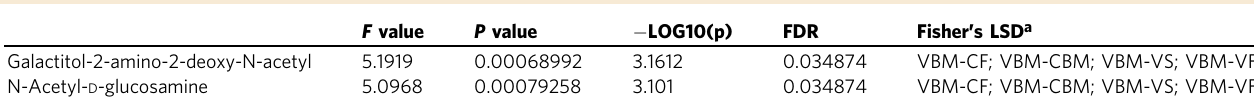
Table 4 List of signi fi cant metabolites among groups at T0.